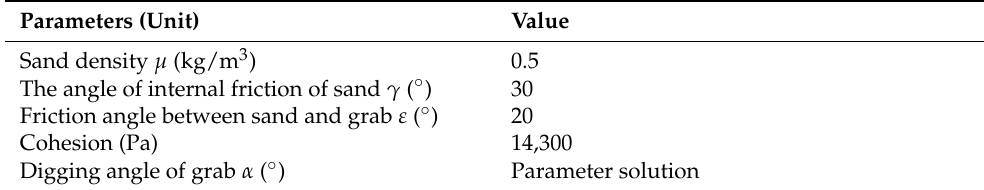
Table 2. Main characteristic parameters.